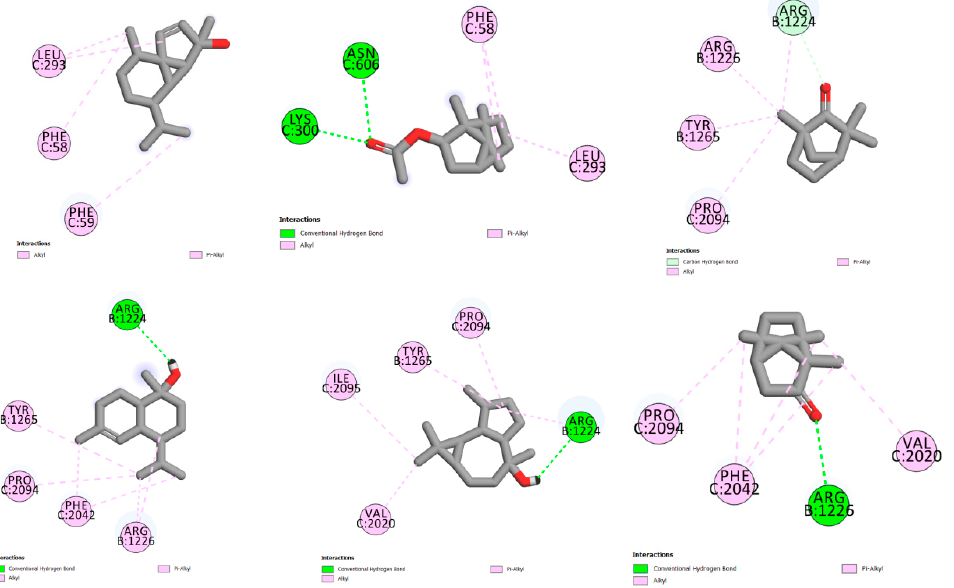
Figure 5. The molecular interactions between the studied compounds and spike glycoprotein receptor (pdb:6vsb) using discovery studio visualizer.